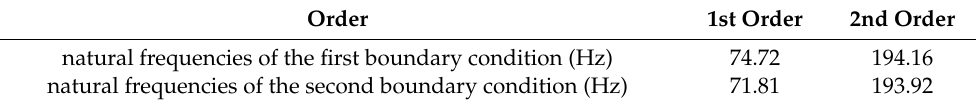
Table 2. The first three-order natural frequencies of the model obtained through theoretical calculation. Order natural frequencies of the first boundary condition (Hz)